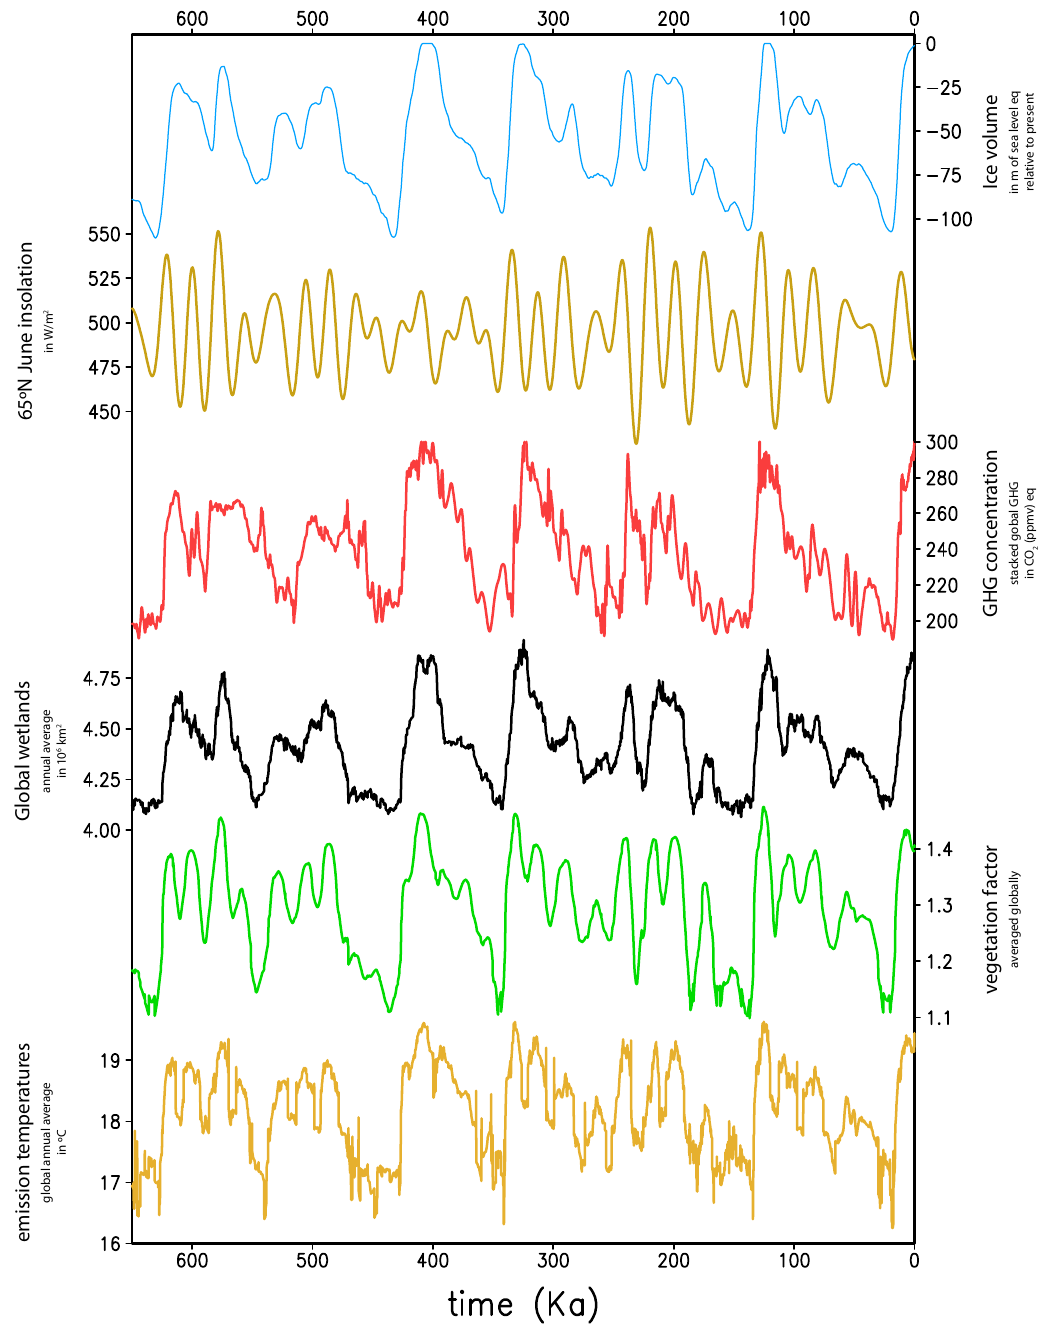
Fig. 4. Transient forcings (top graphs) for CLIMBER-2, ice volume (Bintanja et al., 2005), insolation (Laskar, 2004), and GHG (Loulergue et al., 2008), and the resulting wetland extent, vegetation factor and mean emission temperature (lower